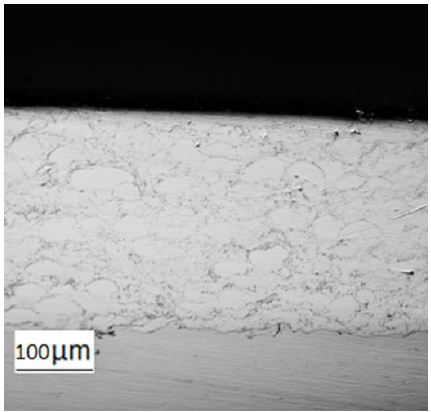
Figure 2. Micrograph of the coating to represent cross section